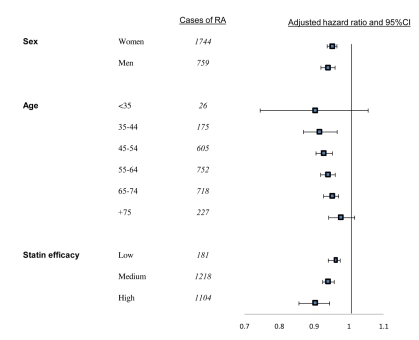
Proportional effects of persistence with statins on reduction of risk for RA per 10% of follow-up days covered with statins.Squares indicate adjusted HRs, horizontal lines, 95% CIs. Mutually adjusted for all covariates listed in Table 4.